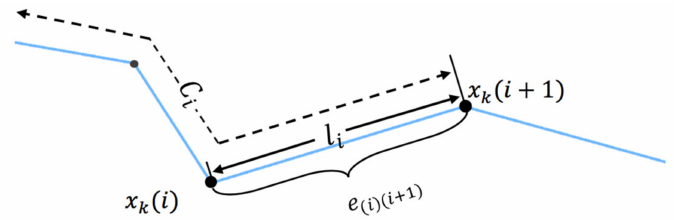
Figure 6. Illustrating graphics of variables involved in finding a set of edges from the route waypoints.